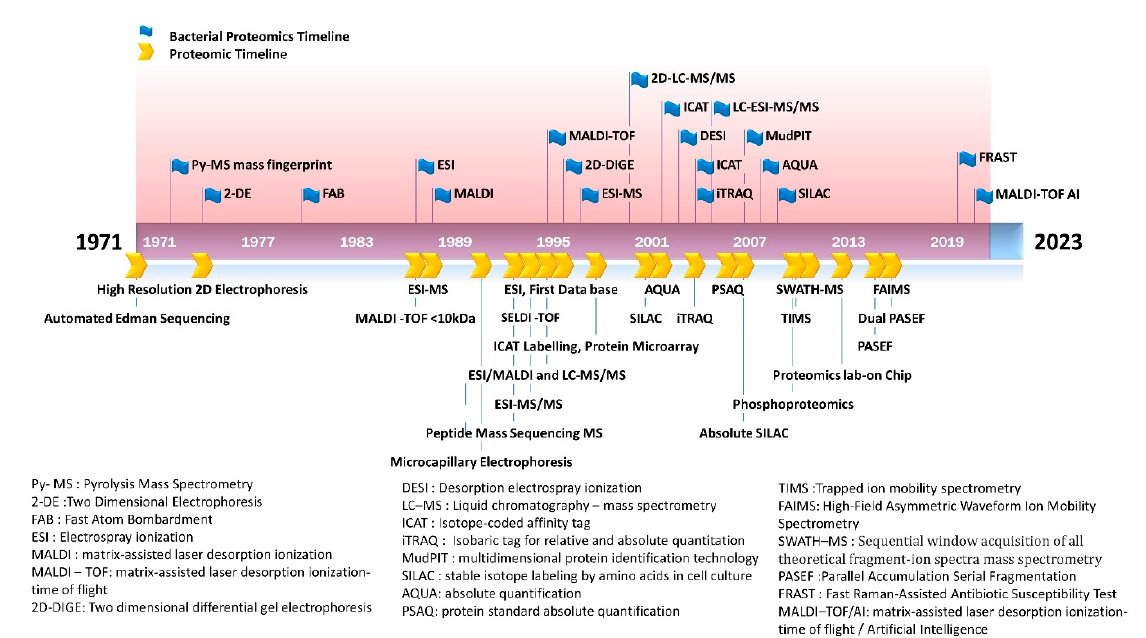
Figure 1. Emergence of bacterial proteomics in line with proteomics milestone. The figure shows the application of proteomic tools in bacterial testing.